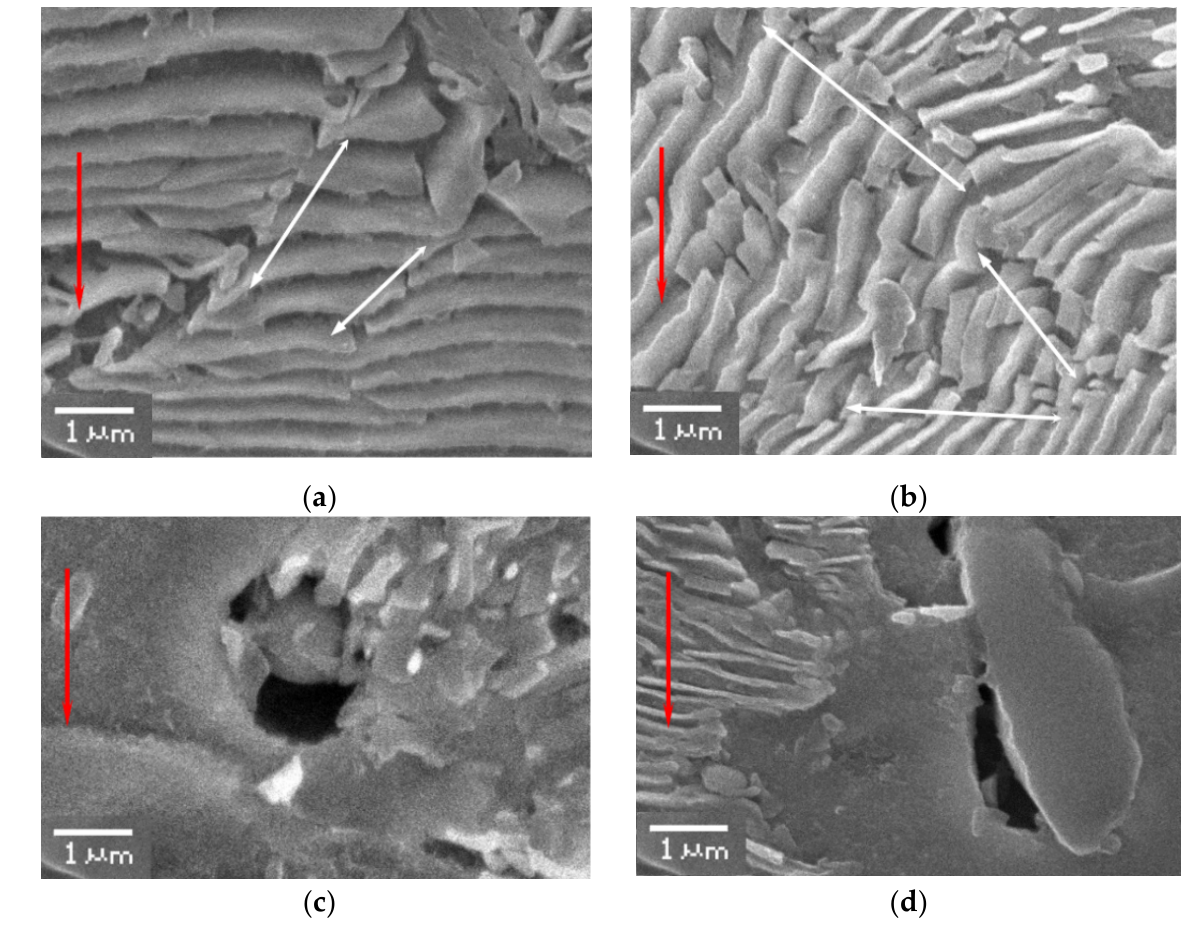
Figure 7. Microstructural damage for strain level ε z 1 = 0.38: ( a , b ) fracture of lamellar cementite at different distances from the free surface of the sample (Zone I) (( a ) 1 mm, ( b ) 2 mm); ( c , d ) nucleation of microvoids by decohesion mechanism (( c ) spheroidal inclusion, ( d ) elongated inclusion (red arrows—direction of upsetting).